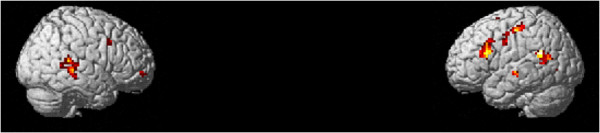
Learning contrasts weighted by overall gain of each subject (puncorrected<0.005, spatial extent=20 voxels, T=3.25).